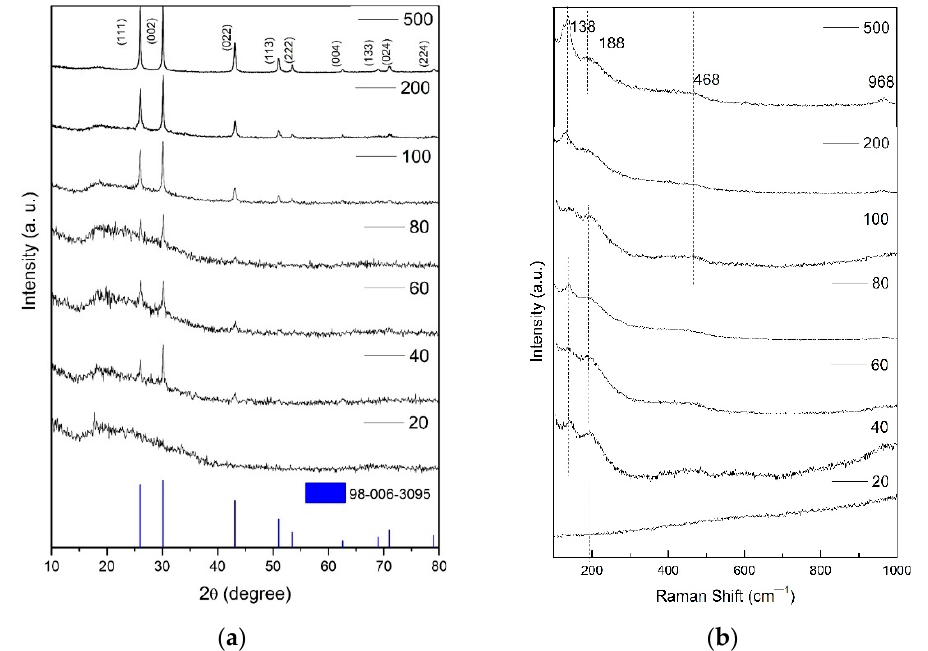
Figure 12. ( a ) X-ray diffractograms and ( b ) Raman spectra of PbS film samples obtained with different number of deposition cycles.